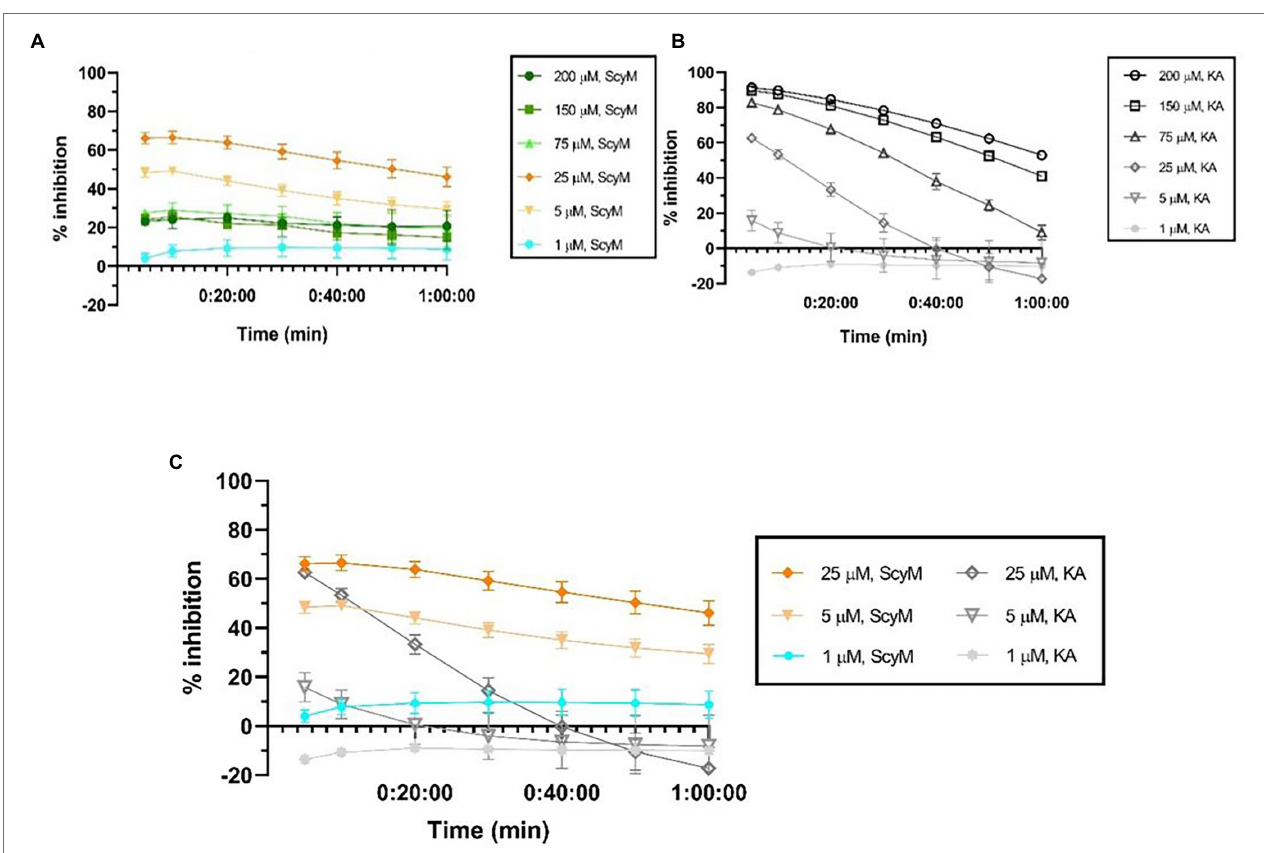
FIGURE 4 | Dose-dependent percent inhibition against tyrosinase over time for: (A) scytonemin monomer (ScyM, 1 ); (B) kojic acid (KA, 3 ), the positive control compound; (C) ScyM and KA at 1, 5, and 25 μ M concentrations at which ScyM completely dissolves in the 0.067 M sodium phosphate buffer and does not have solubility problems. Experiments were carried in triplicate and error bars represent standard